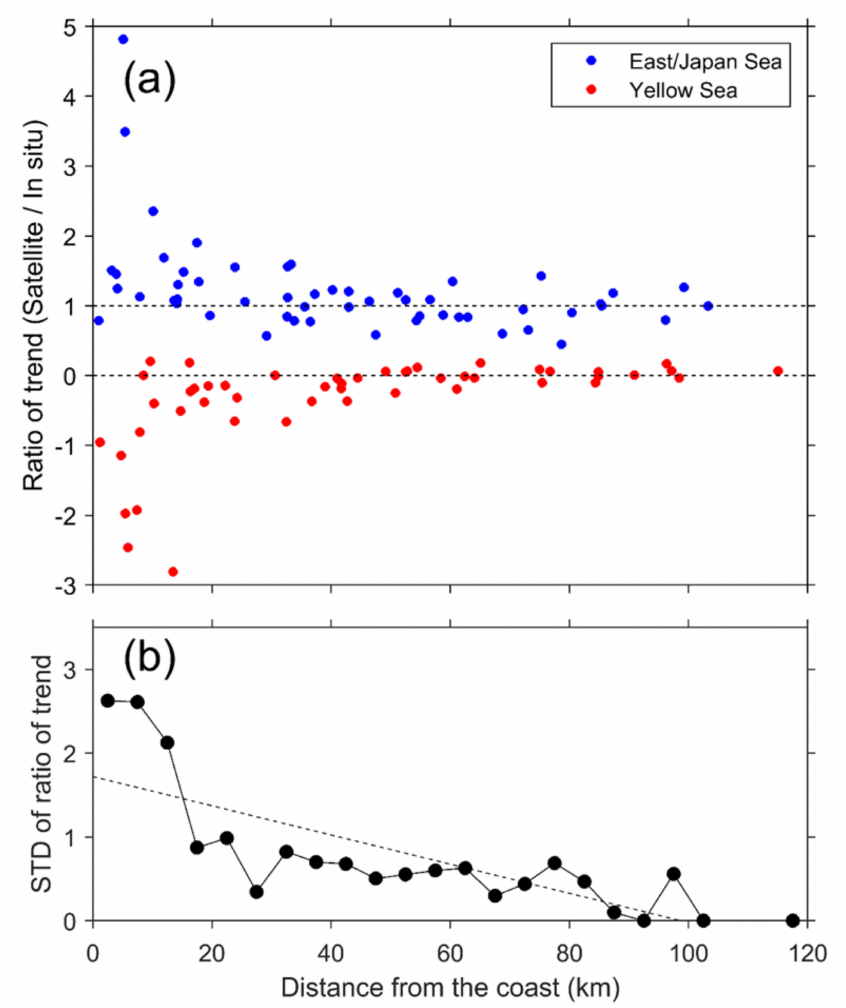
Figure 12. ( a ) Ratios of satellite SST trends to in situ temperature trends as a function of distance from the coast (km) in the East / Japan Sea (EJS) (blue dot) and the Yellow Sea (YS) (red dot) and ( b ) standard deviation (STD) of the trend ratios with respect to the distance from the coast (km) in the EJS and the